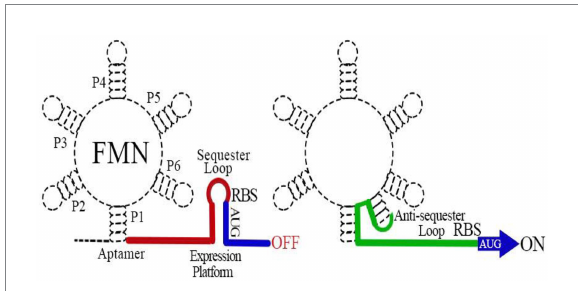
FIGURE 2 Schematic map of the flavin mononucleotide (FMN) riboswitch mechanism of action. The FMN riboswitch includes two main parts: the 5 ′ mRNA aptamer and the 3 ′ downstream expression platform. When FMN binds to the aptamer, the expression platform conforms to a sequester loop (Pritchett and Reddy, 2017) that inhibits ribB expression through early termination of transcription of the ribB and sequestration of the ribosome binding sequence to prevent translation of fully transcribed ribB mRNAs. In the absence of FMN, the aptamer ligand-binding domain adopts an alternative structural conformation that induces an anti-sequester loop (green) in the 3 ′ downstream expression platform, allowing the continuous expression of ribB.